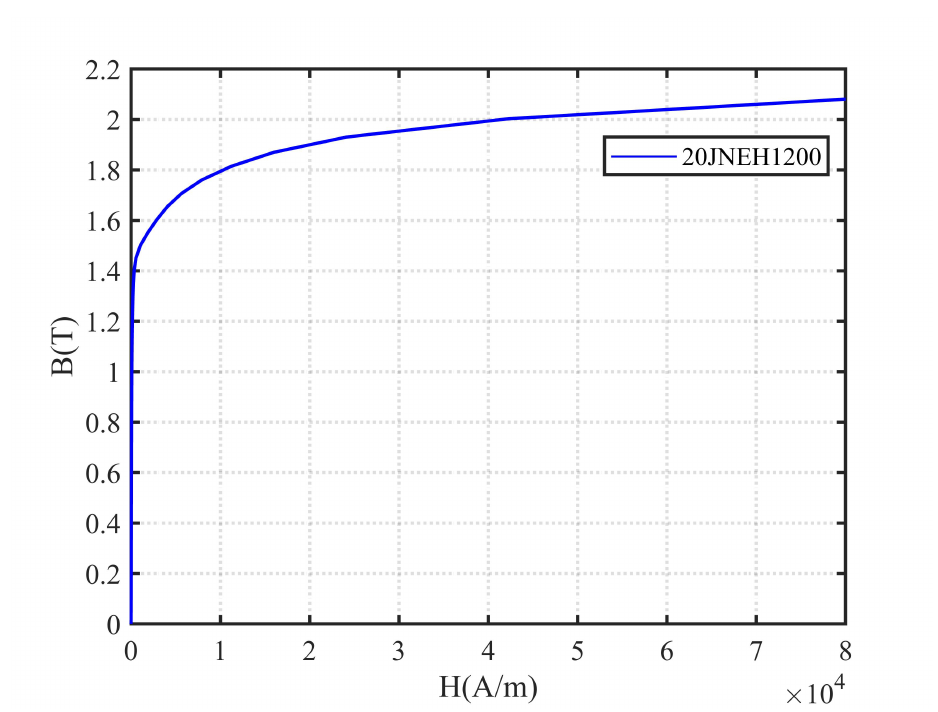
Figure 4. B-H Curves of